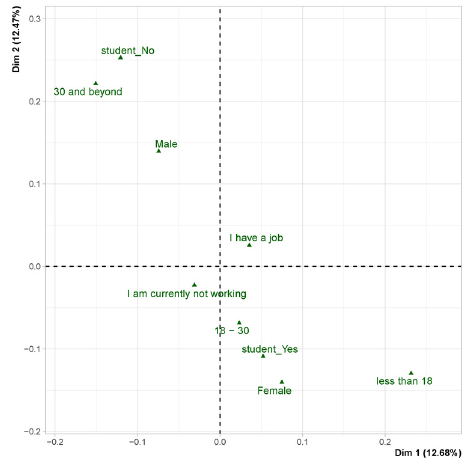
Figure A3. MCA. Supplementary categories.